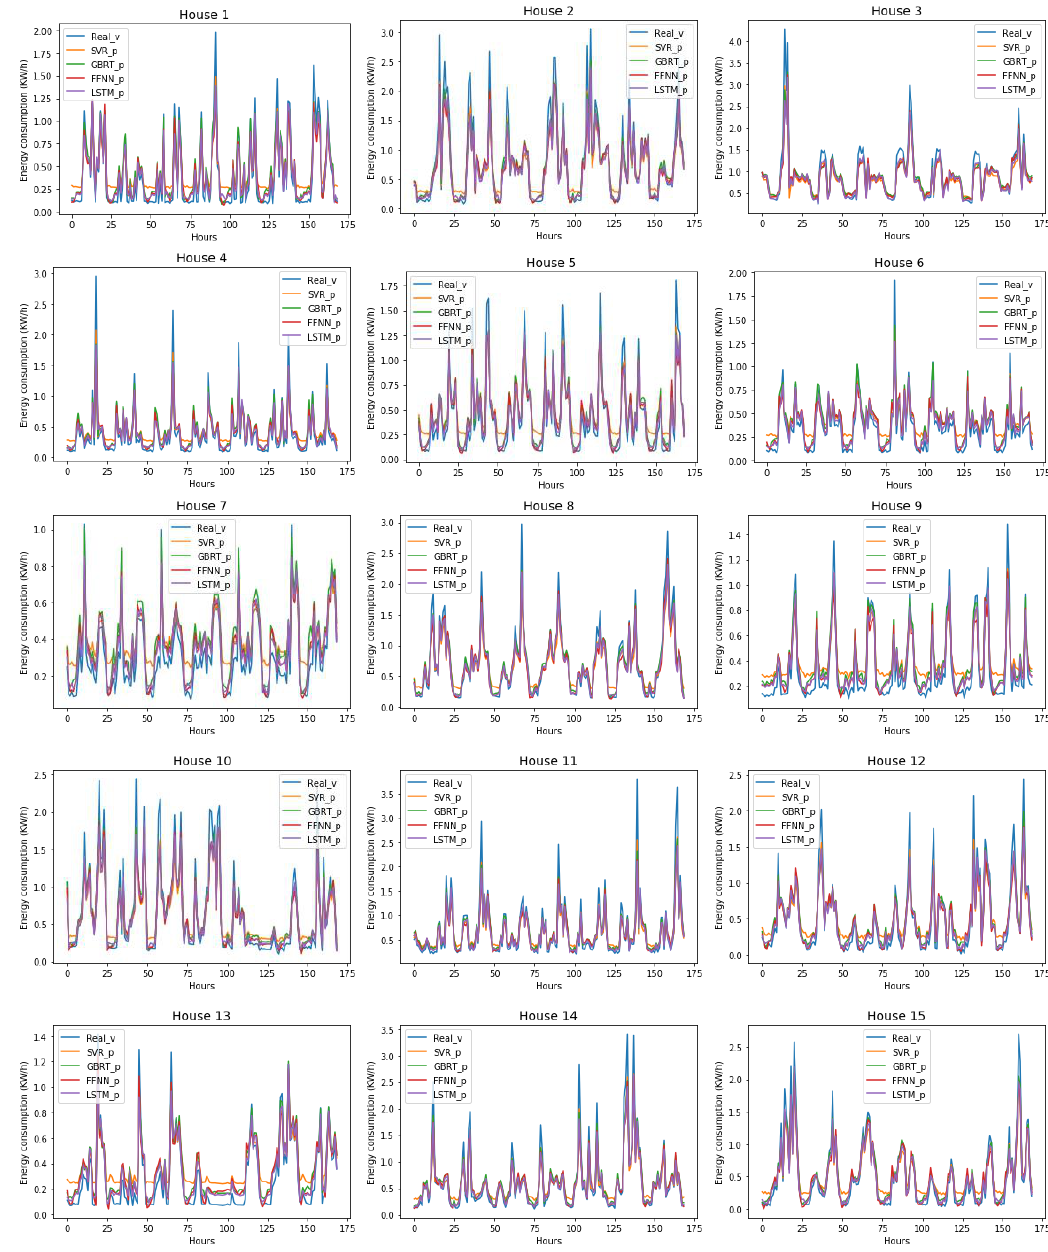
Figure 8. Real consumption of test houses versus predictions over one week.